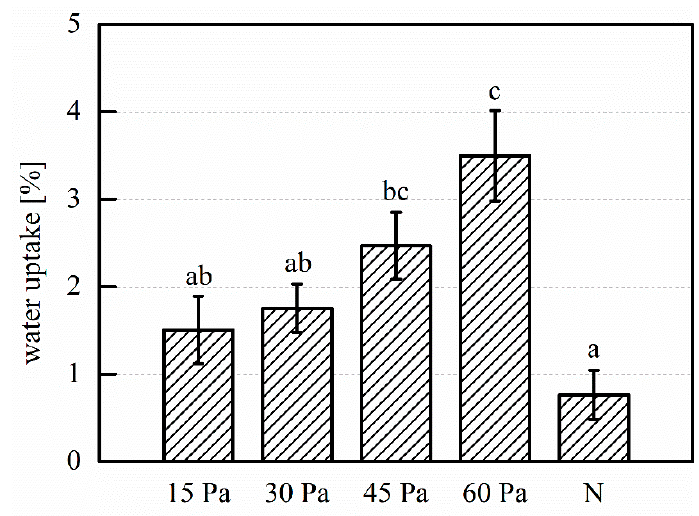
Figure 5. Mean mass increase of the clove after 30 minutes of soaking. 15 Pa, 30 Pa, 45 Pa, 60 Pa: plasma treatments at the indicated working pressure; N: untreated control. Number of replications: n = 5. Error bars indicate standard error. Different letter labels indicate statistically significant differences ( p < 0.05).